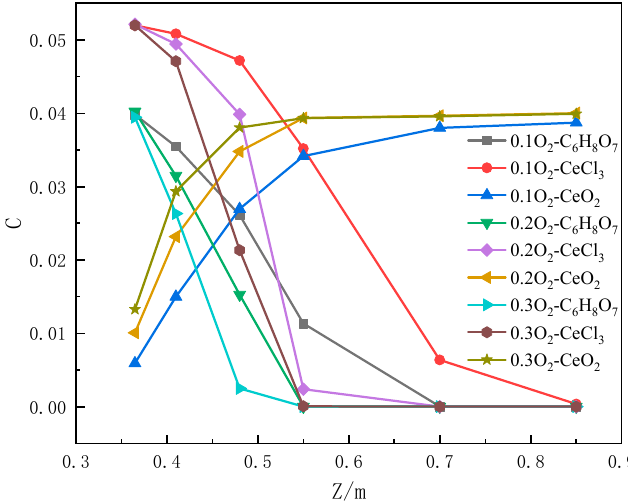
Figure 9. Solid particle concentration curves with respect to the O 2 ratio.